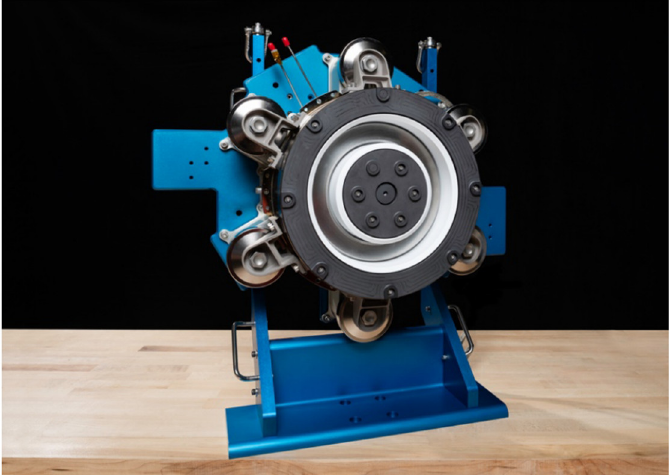
Figure 8. Magnetically-shielded Advanced Electric Propulsion System (AEPS) Engineering Test Unit 1. Image reprinted with permission from [11], NASA, 2019.